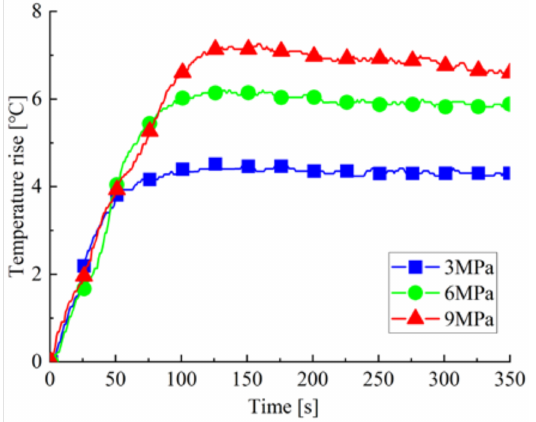
Figure 17. Measured data of the change in heat dissipation of oil in a sealed cavity under different